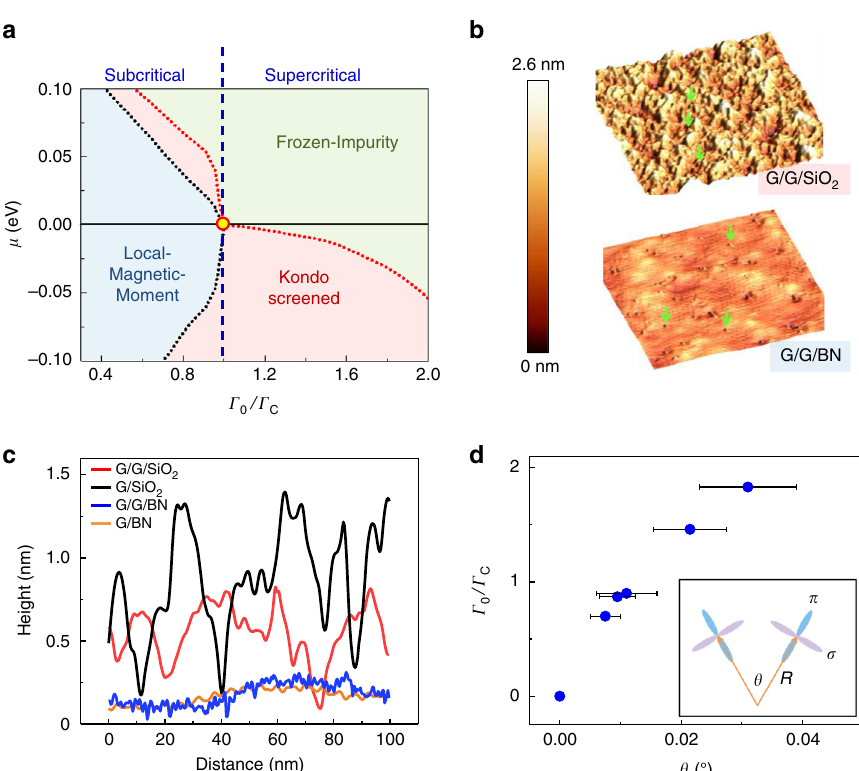
Fig. 4 Quantum phase transition and Kondo screening. a μ − Γ 0 phase diagram at 4.2 K. The critical coupling Γ C (circle at Γ 0 / Γ C = 1.0) designates the boundary between Frozen-Impurity and the Local-Magnetic-Moment phases at μ = 0. Dotted lines represent boundaries between the phases (Supplementary Note 8). b STM topography for the G/G/SiO 2 (top) and G/G/BN (bottom) samples with the same scale bar ( V b = − 300mV, I = 20pA). The arrows point to the vacancies. c Typical line pro fi le of the STM topographies of graphene on different substrates with the same scanning parameters as in b . d The evolution of the hybridization strength with the curvature. Error bars represent the uncertainty in obtaining the angle between the σ -orbital and the local graphene plane orientation from the local topography measurements. Inset: sketch of the curvature effect on the orbital